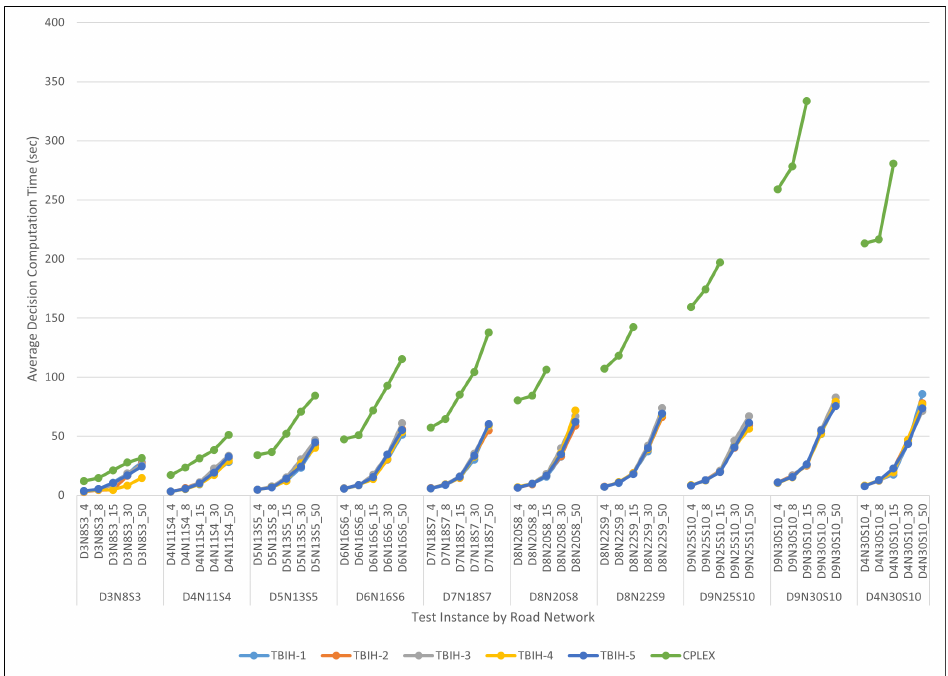
Figure A19. Algorithms performance compared to matheuristic rollout applied in PDS-RA: best average decision computation time (sec) measured based on test